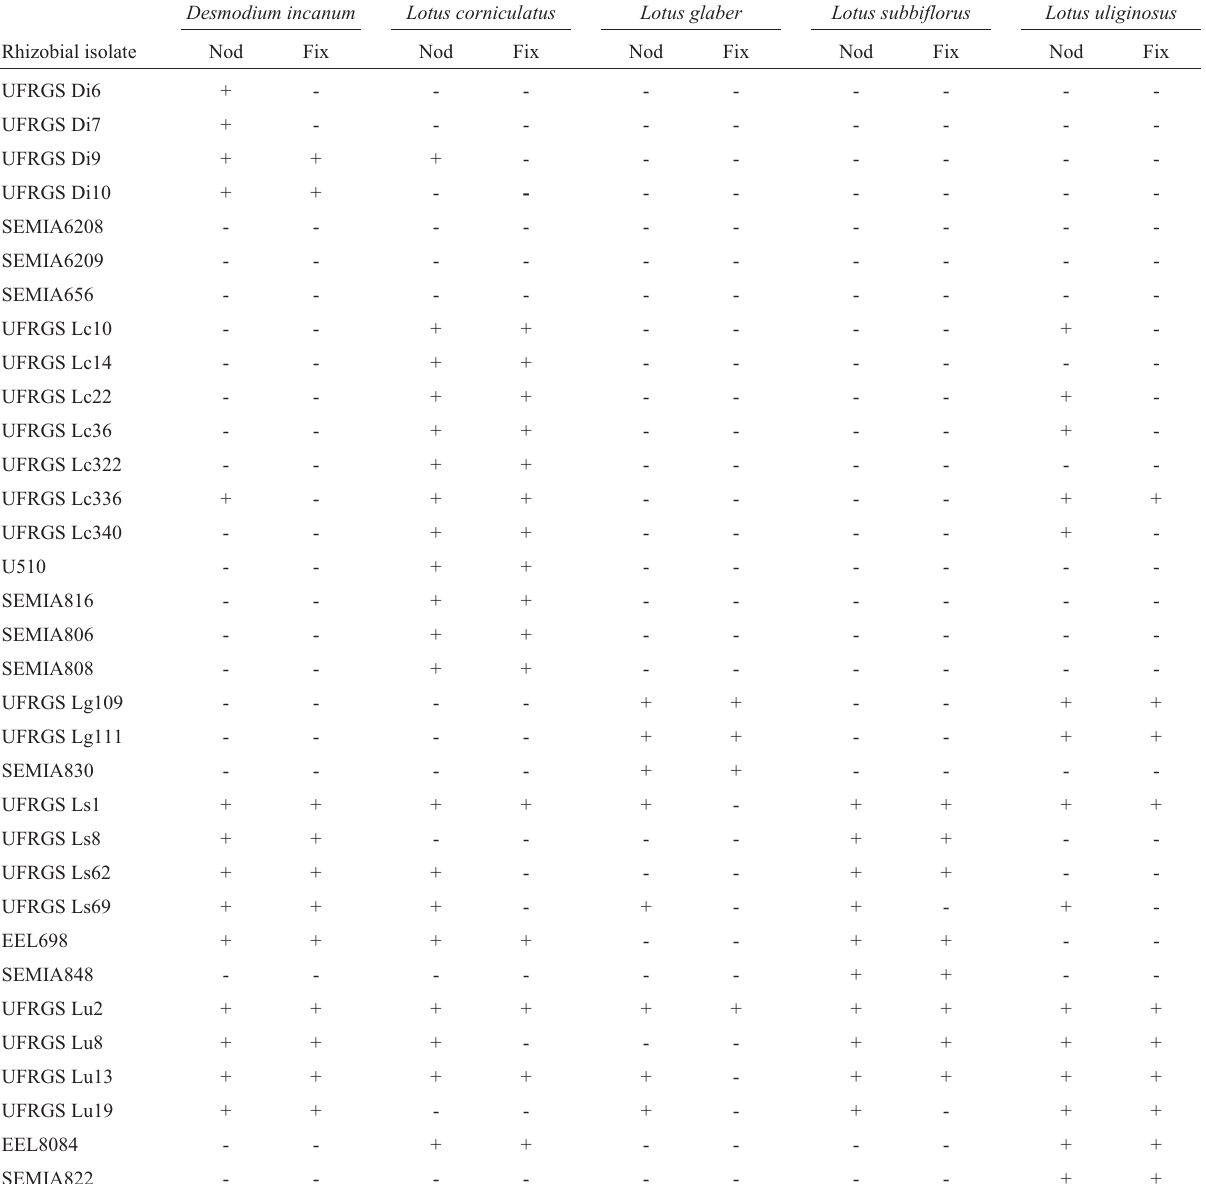
Table 2 - Cross-inoculation results among the native rhizobial and reference strains and the five plant species studied in this work. Desmodium incanum Lotus